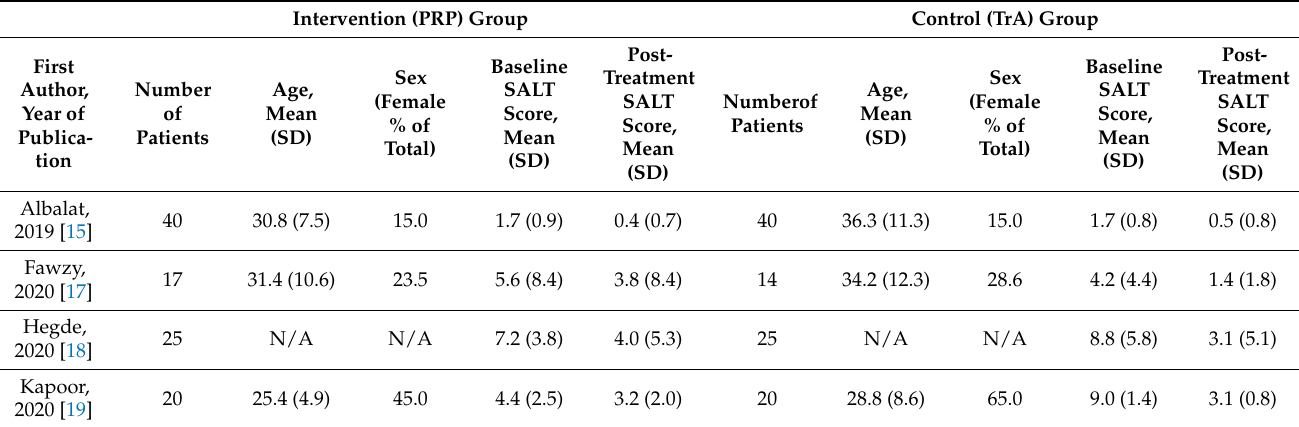
Table 2. Patient characteristics of the studies included in the meta-analysis.